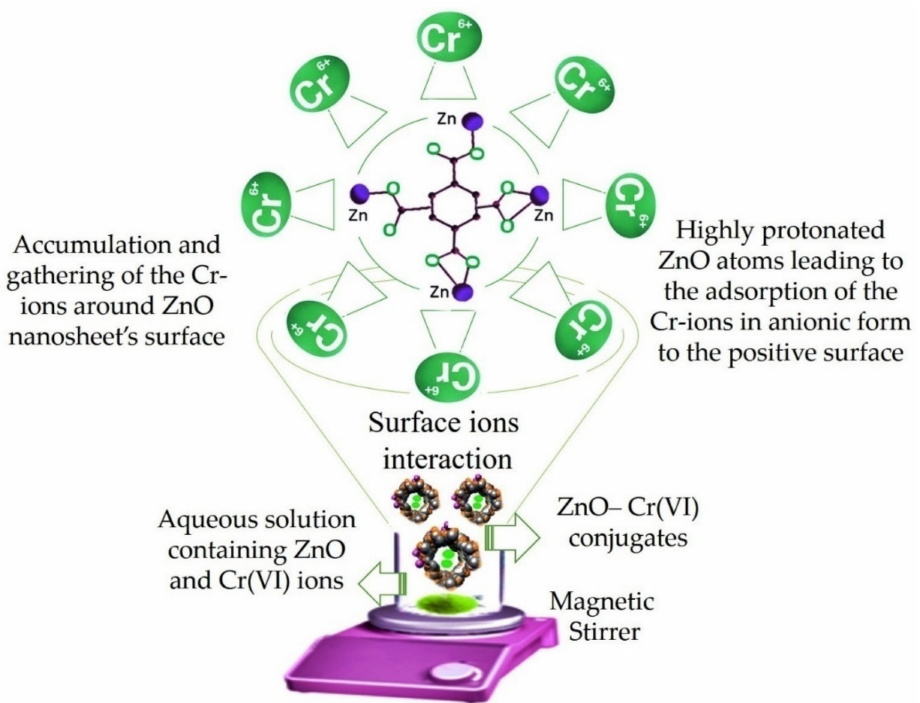
Figure 8. A plausible removal mechanism of Cr(VI) adsorption through ZnO nanosheets.